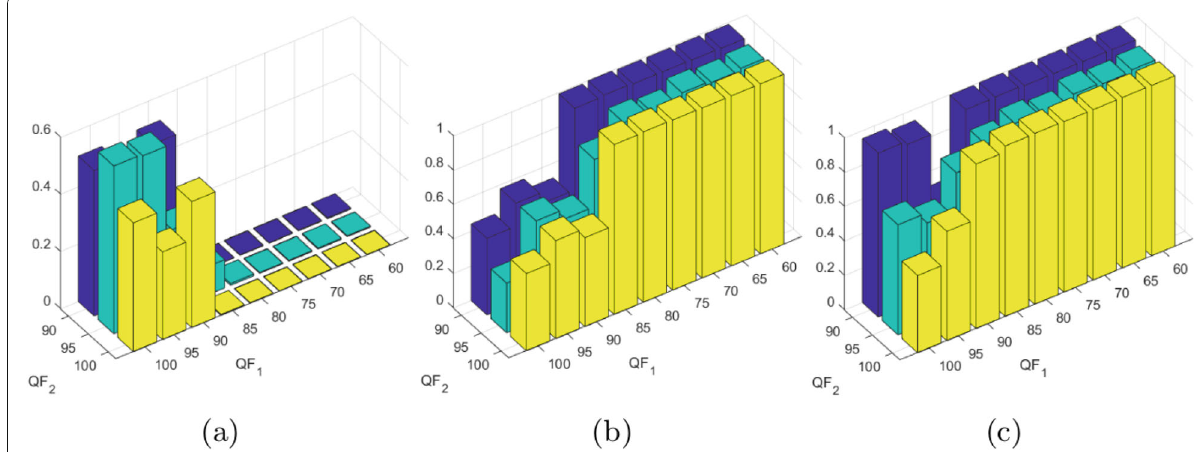
Fig. 8 Overall accuracy of the proposed method on JPEG triple compressed images with high QF 2 (90,95,98), patch size 256 × 256 and QF 3 = 90, considering as ground truth (i.e., correct estimations) the quantization factors related to QF 2 (a), QF 1 (b) and both